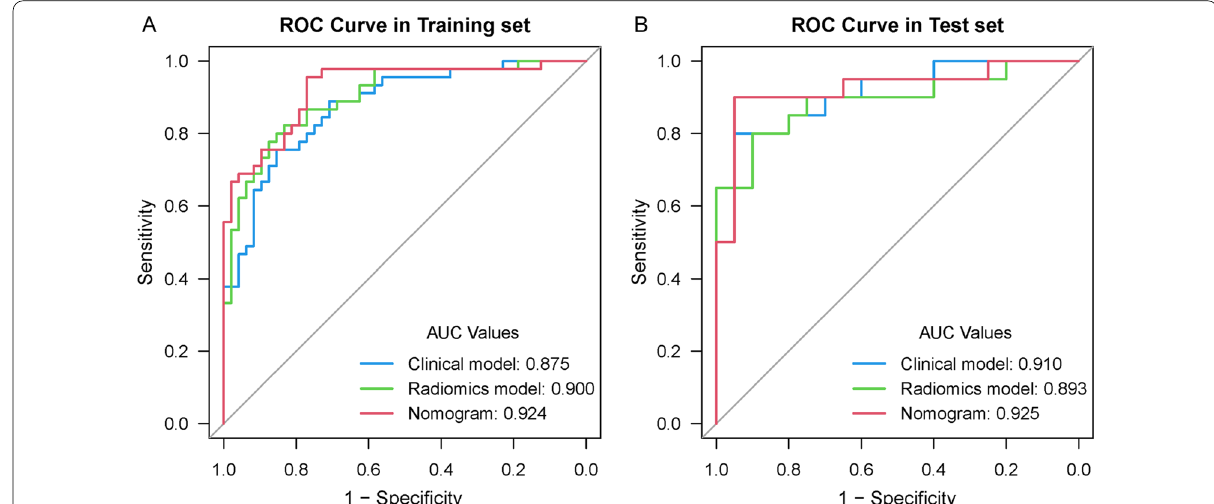
Fig. 6 A Receiver operating characteristic (ROC) curves for the clinical model, radiomics model and nomogram in the training set. B ROC curves for the clinical model, radiomics model and nomogram in the test set